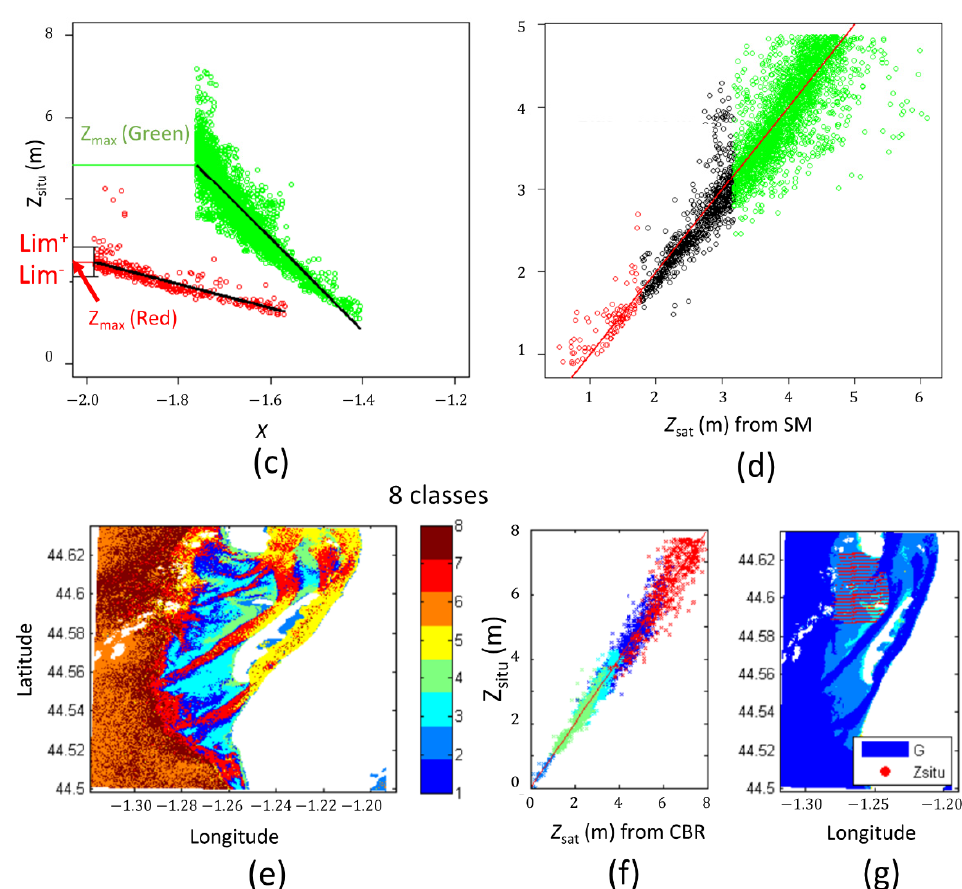
Figure 3. Illustration of the satellite-derived bathymetry linear regression (LRM), switching (SM), and cluster-based regression (CBR) methods for the 10 September 2020 Sentinel-2 cropped image. ( a ) Data filtration procedure for the green band. X is the log-transformed green band. Z situ is the field-reduced depth (in m). The entire range of X values are divided into 20 bins of equal sizes comprised between X min and X min . N bin and σ bin are the number of observations and the standard deviation of Z situ values per bins, respectively. When N bin is lower than 30 or σ bin higher than 1 m, observations of the bin are removed (blue points). The red line is associated with the linear regression model for the green band (LRM-G) computed from filtered observations (black points). Z min and Z max correspond to the minimum and maximum values of Z sat computed from LRM-G. ( b ) Comparison between Z sat derived from LRM-G and Z situ . ( c ) Computation of the linear regression model for the red band (LRM-R), Z max and switching points ( lim − , lim + ). ( d ) Comparison between Z sat derived from SM using LRM-R and LRM-G and Z situ . Black points are associated with the smoothing interval. ( e ) Example of classification of satellite image pixels into 8 optical classes using a k-means classifier. ( f ) Comparison between Z sat derived from CBR and Z situ . The color of points is associated with the color of optical classes. ( g ) Location of Z situ data points used in this example for calibration of LRM, SM, and